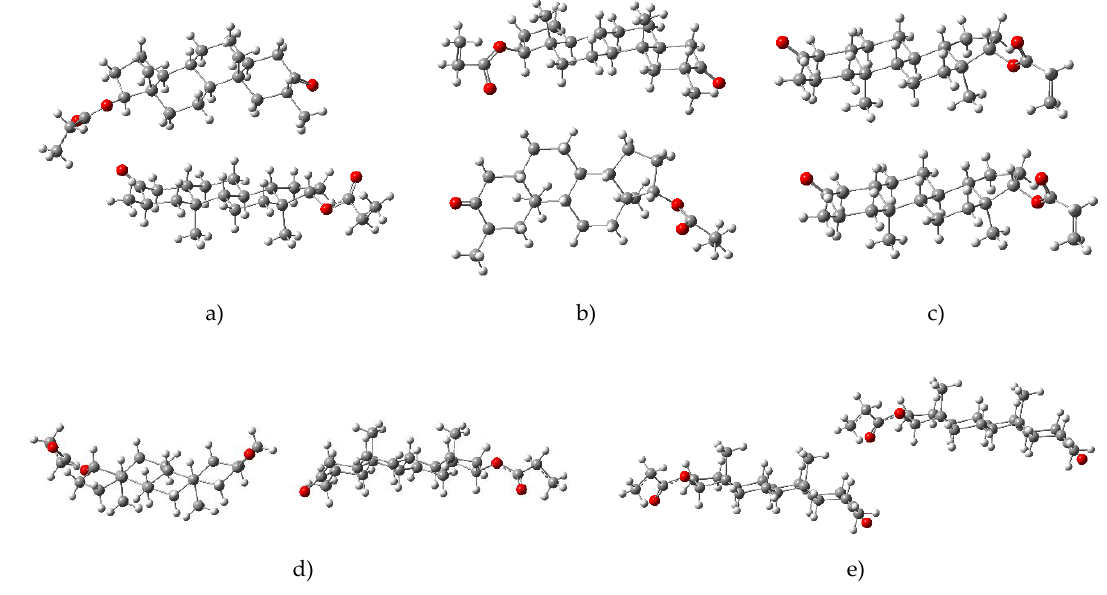
Figure 9. The geometry configurations of the five dimer geometries characteristic for the Drost 2 unit cell’s close contacts. The dimer geometries are indexed from a )– e ).